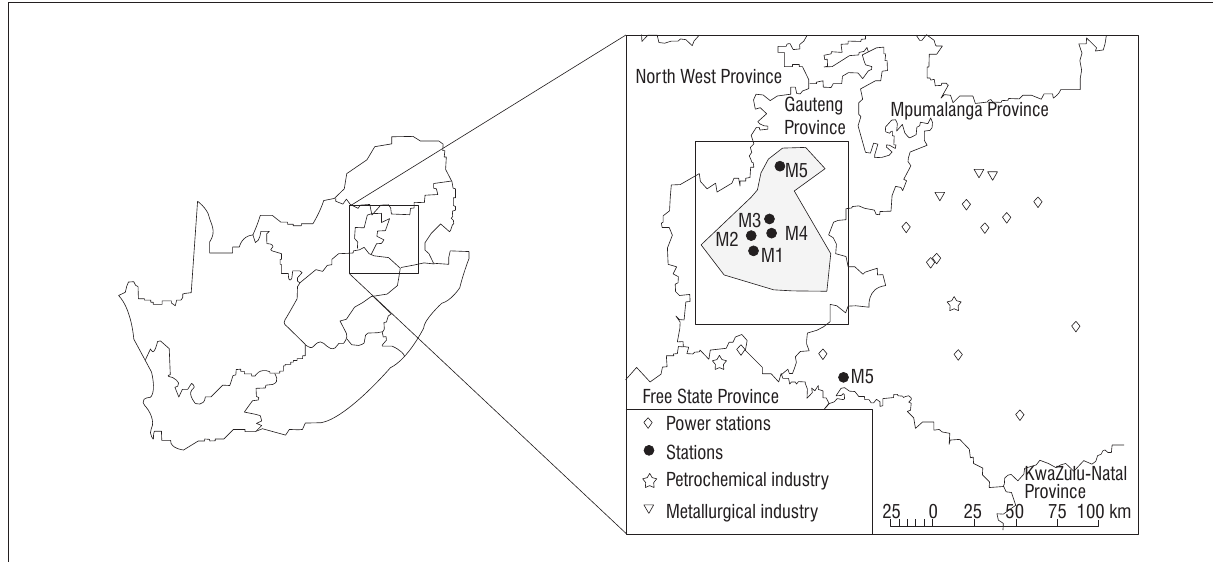
Figure 1: Model domain under investigation, with sampling stations in the Johannesburg-Pretoria (Jhb-Pta) megacity also shown. The Jhb-Pta megacity is indicated by the grey